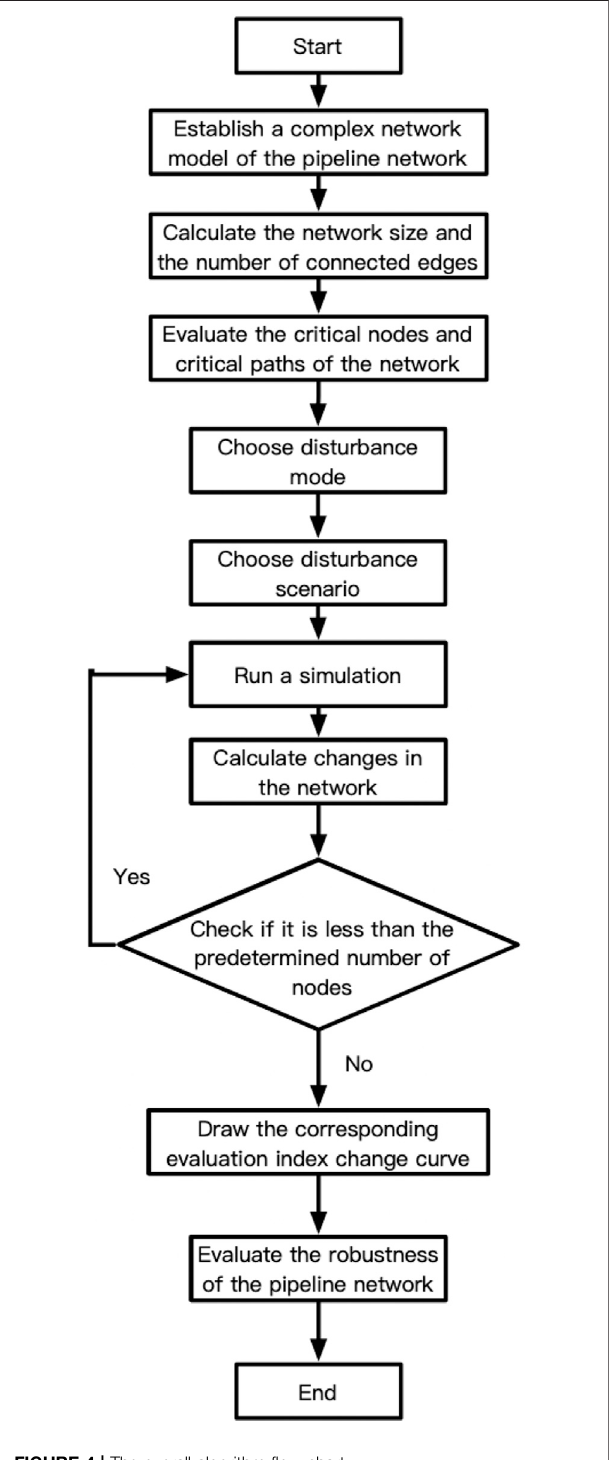
FIGURE 4 | The overall algorithm fl ow